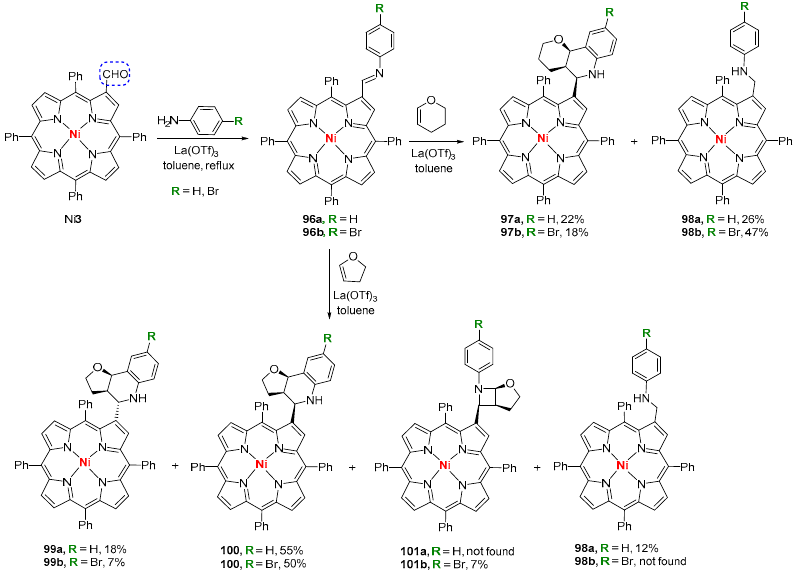
Scheme 23. Reaction of β -CHO- m -MeOTPP with aminotriazole 91a and isoniazid [147].